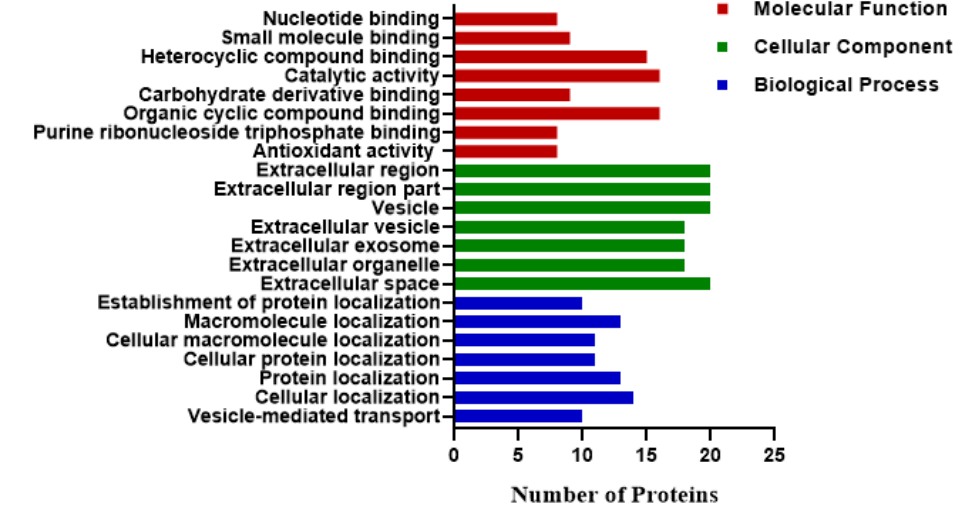
Figure 5. Gene ontology (GO) enrichment analysis ( p < 0.05) of DEPs ( p -value < 0.05 and FC ± 1.2). Proteins were classified according to their molecular functions, localization in cellular components, and participation in the biological process. The results displayed the number of proteins participating in each category.